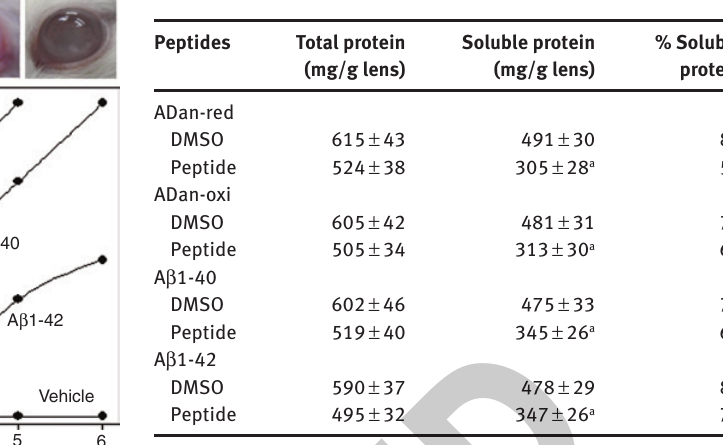
Table 1: Protein content of the lens.